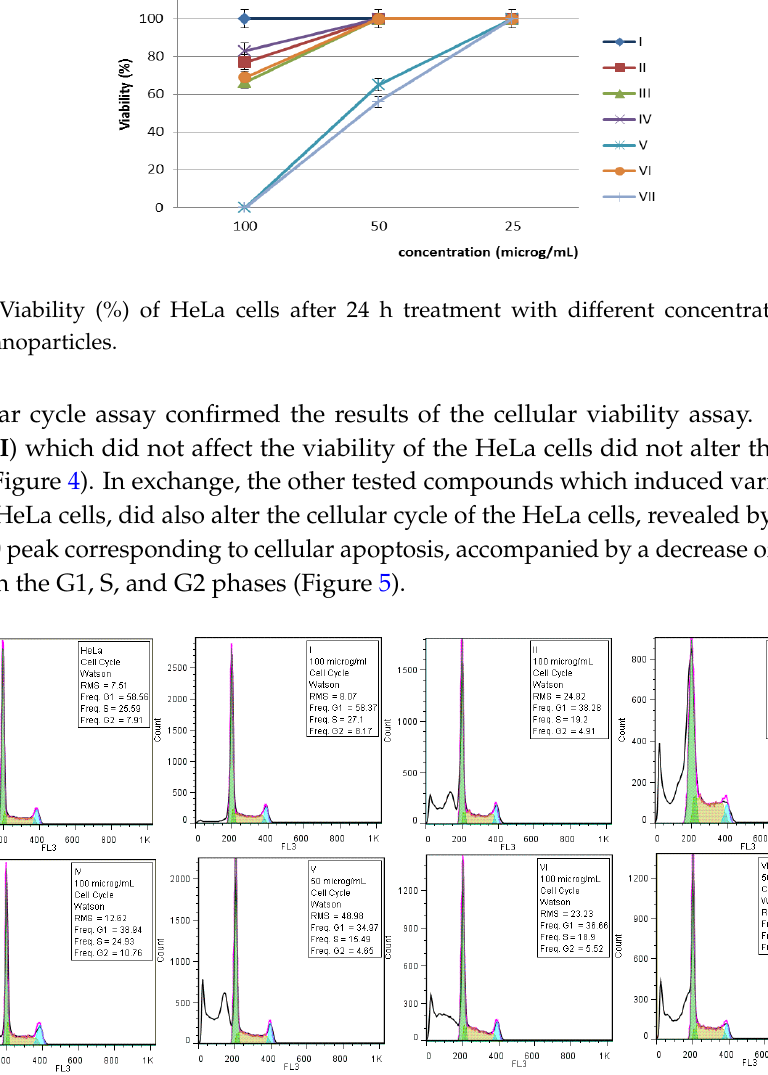
Figure 5. Flow cytometry diagrams of the HeLa cells’ cycle analysis grown in the presence of the tested nanoparticles.